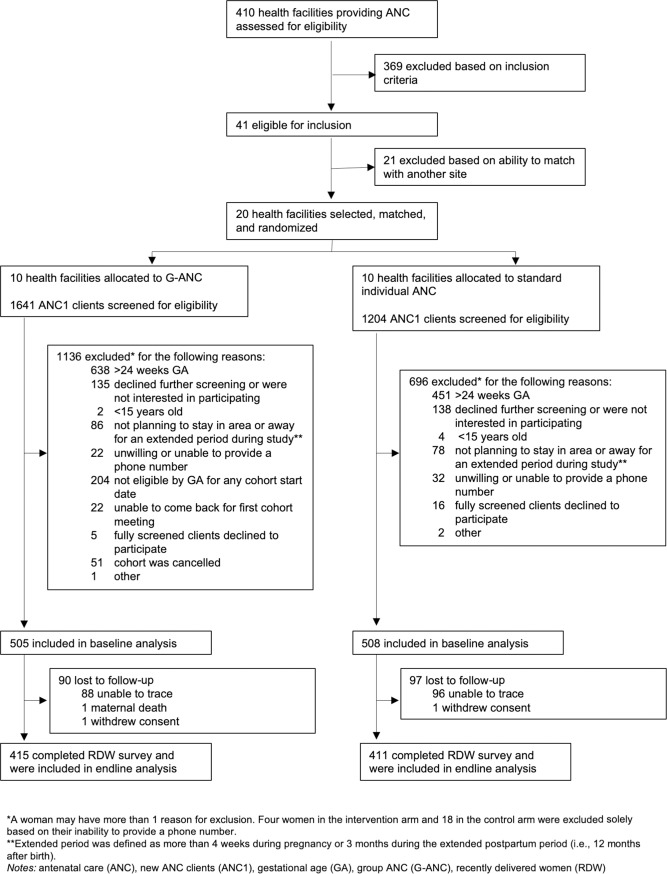
Trial Profile Kenya.